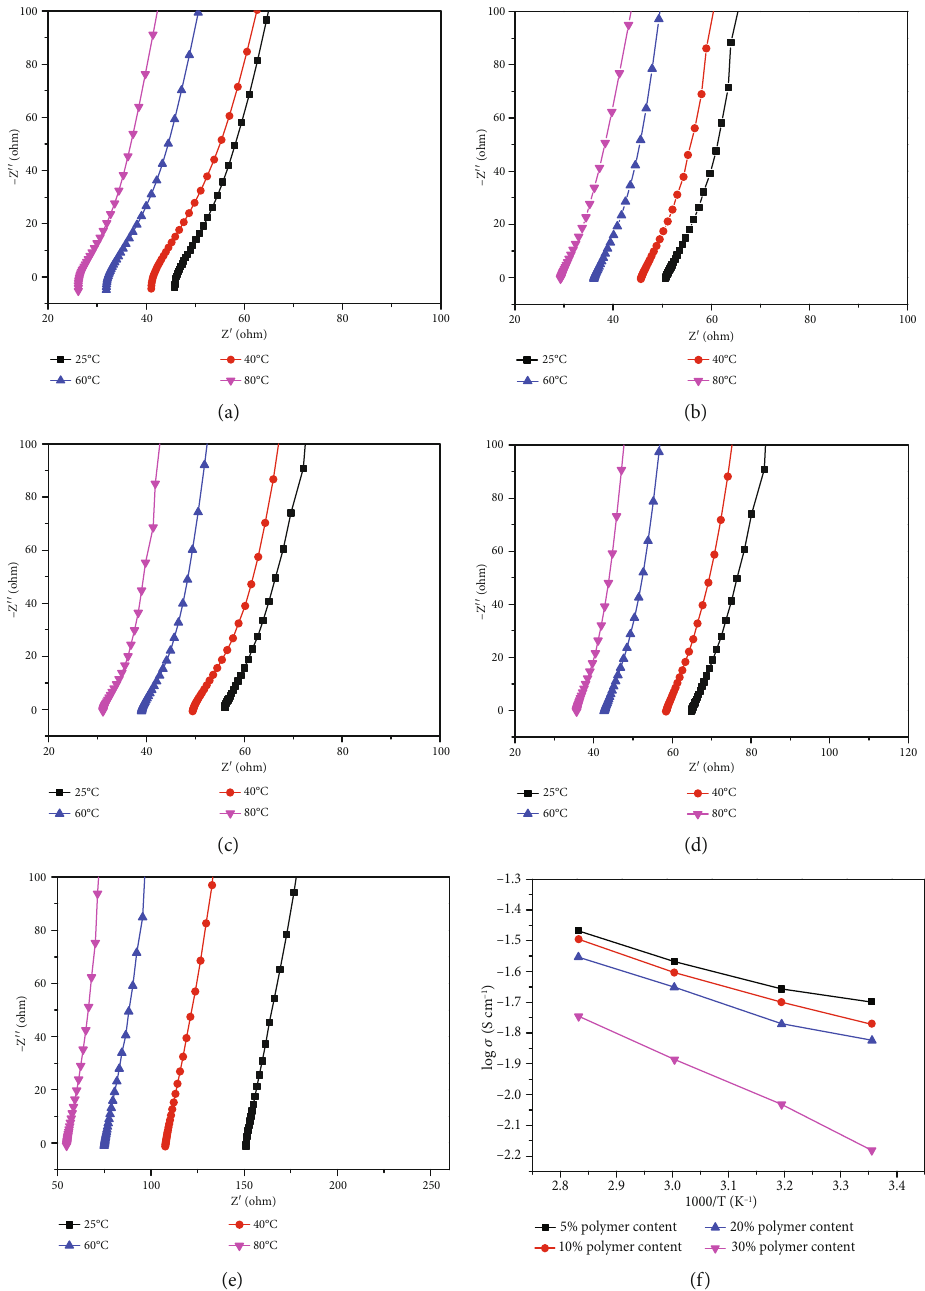
Figure 4: EIS plots for (a) liquid electrolyte and (b) 5% polymer content, (c) 10% polymer content, (d) 20% polymer content, (e)30% polymer content PPCAGE-g-PEG gel at di ff erent temperatures. (f) Temperature characteristic curves of ionic conductivity of PPCAGE-g-mPEGs with di ff erent polymer